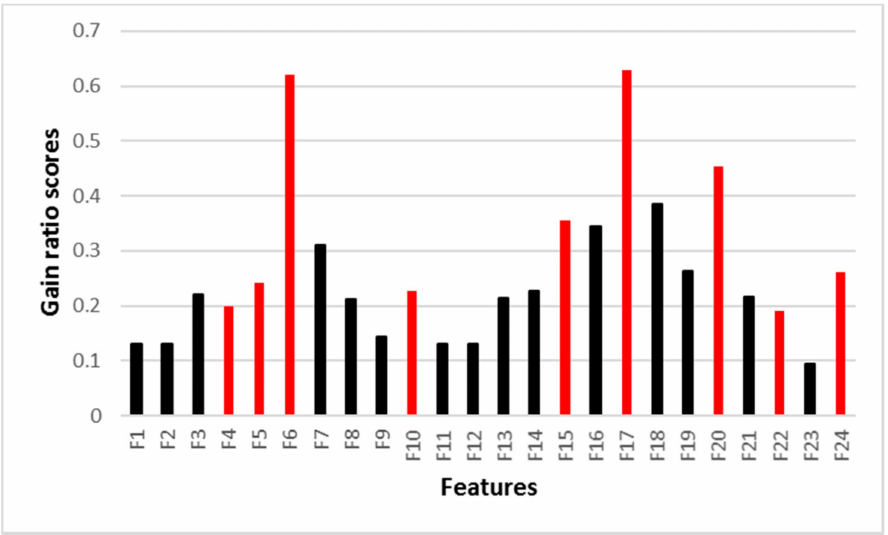
Figure 8. Feature importance evaluation and optimal feature set selection. Red bars represent the selected features in the optimal feature